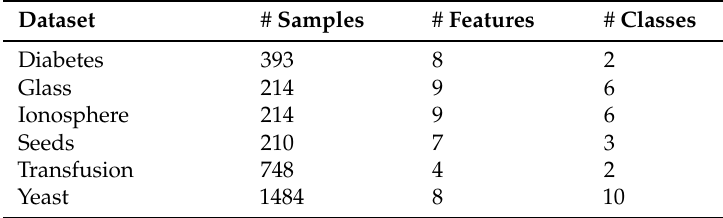
Table 3. Description of the real datasets employed in the study.